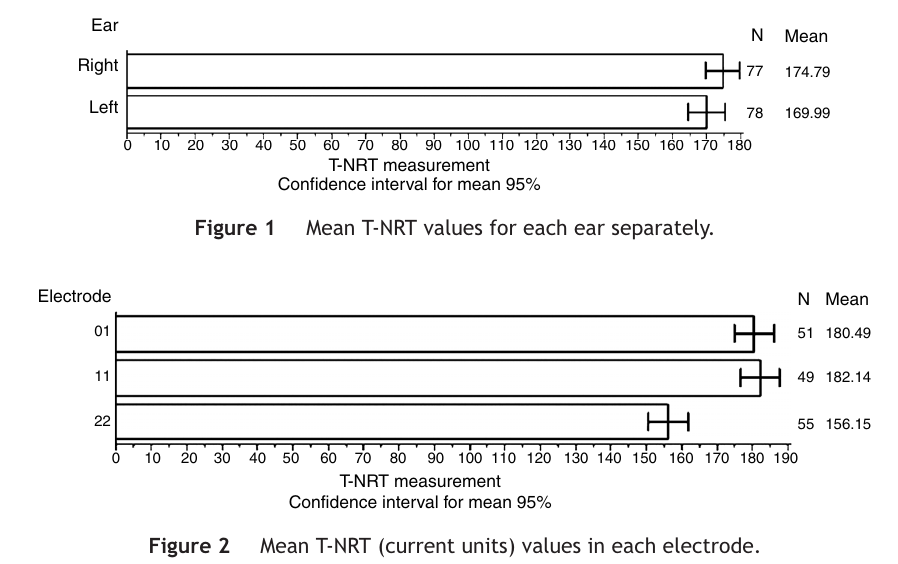
T-NRT measurement Confidence interval for mean 95% Figure 2 Mean T-NRT (current units) values in each electrode.